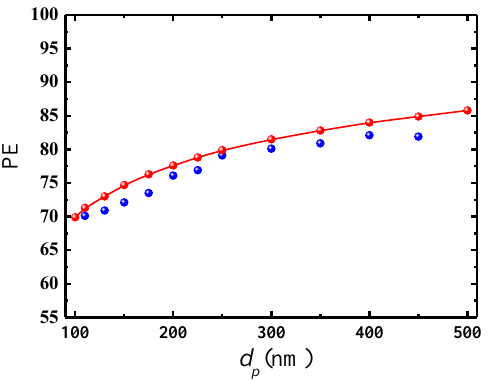
Figure 2. Probability distribution of mean cylindrical particle orientation ( λ = 8, Re = 10,000). ●: numerical results and ●: experimental results [24].